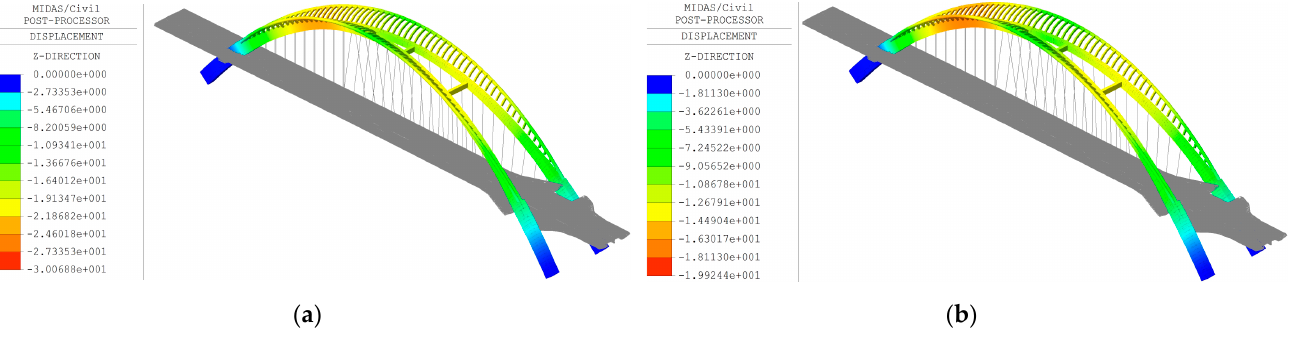
Figure 11. The vertical displacement of the main arch rib and secondary arch rib (unit: mm): ( a ) vehicle load; ( b ) crowd load.